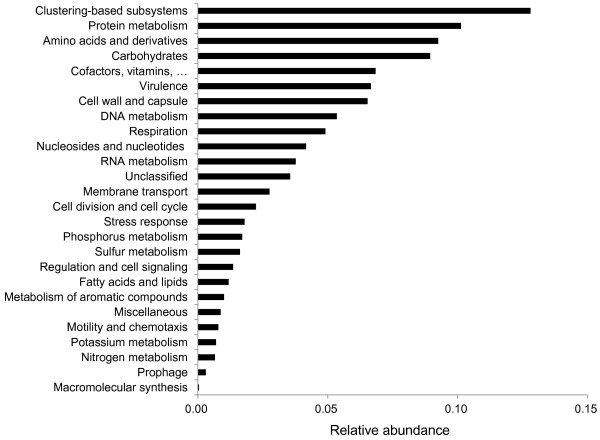
Functional profile of the cecal microbiota of the flying squirrel according to the SEED Subsystem Hierarchy 1.